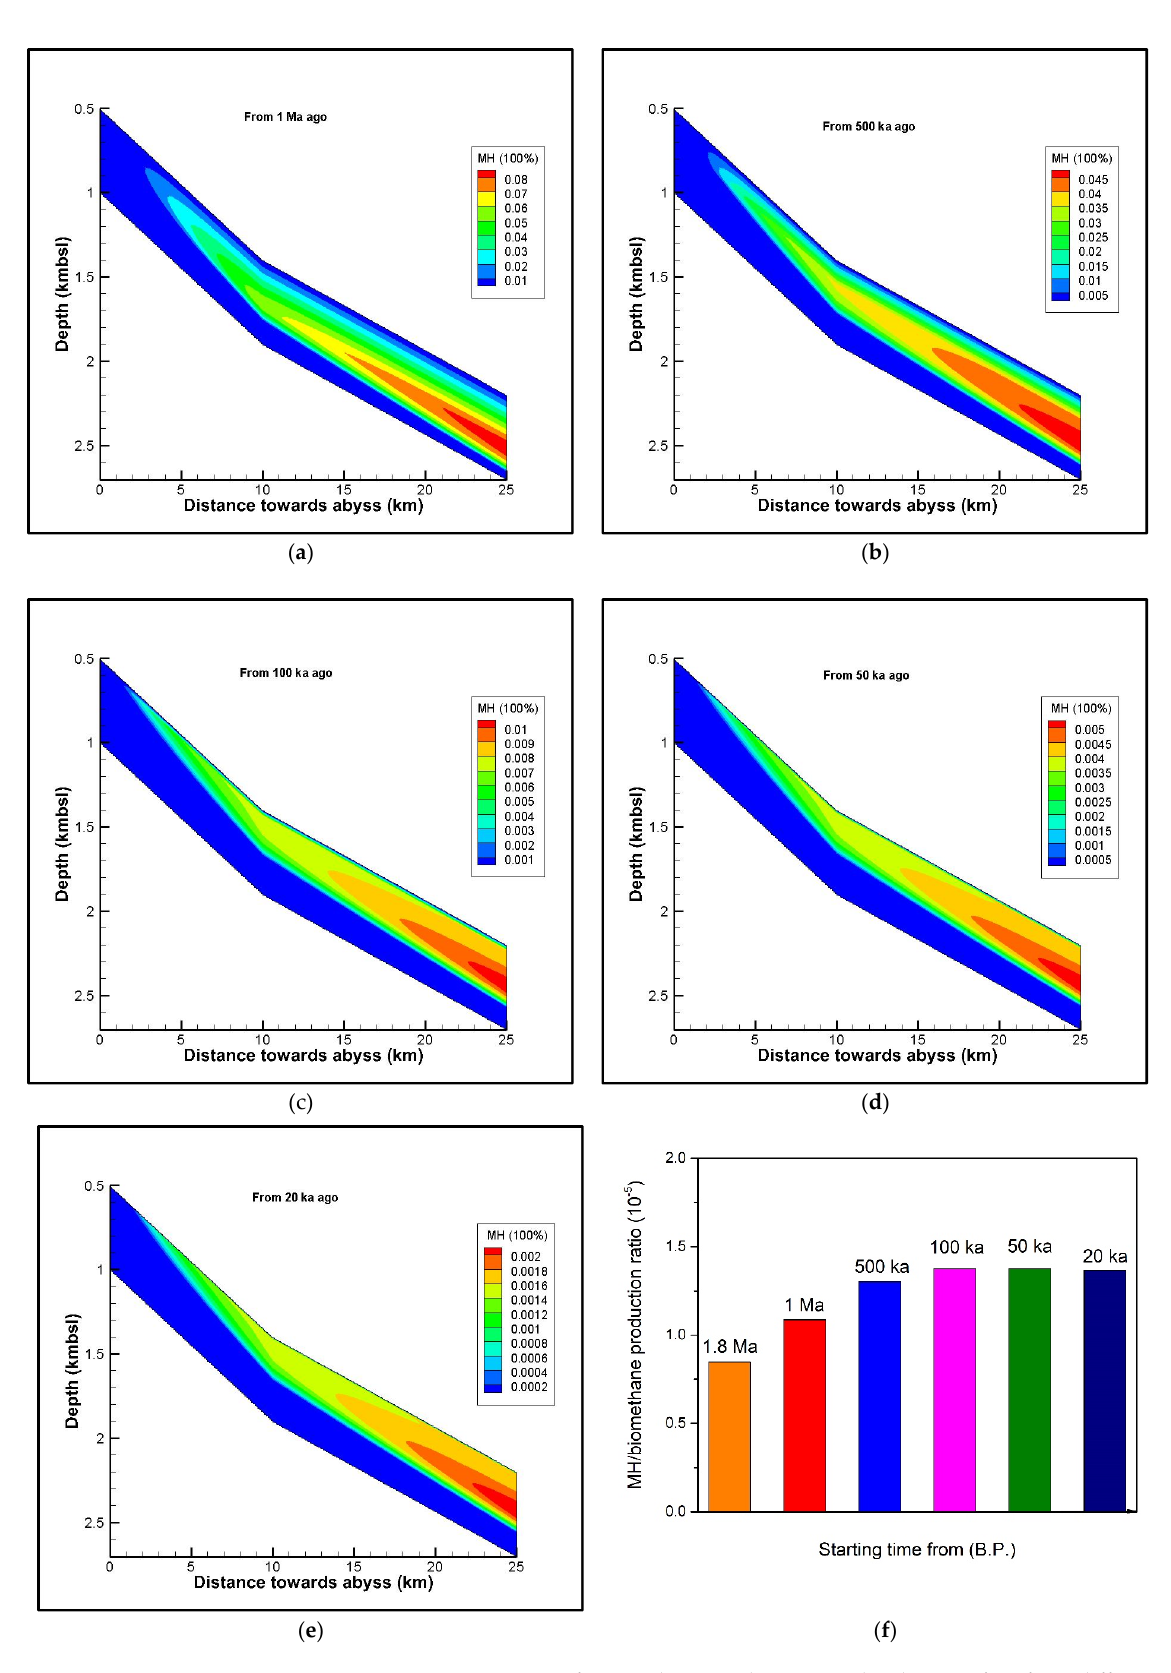
Figure 15. Current occurrence of MH sediments along Dongsha slope surface from different starting times, including 1 Ma ( a ), 500 ( b ), 100 ( c ), 50 ( d ), 20 ( e ) and ka B.P. ( f ), and corresponding carbon ratios ( f ).